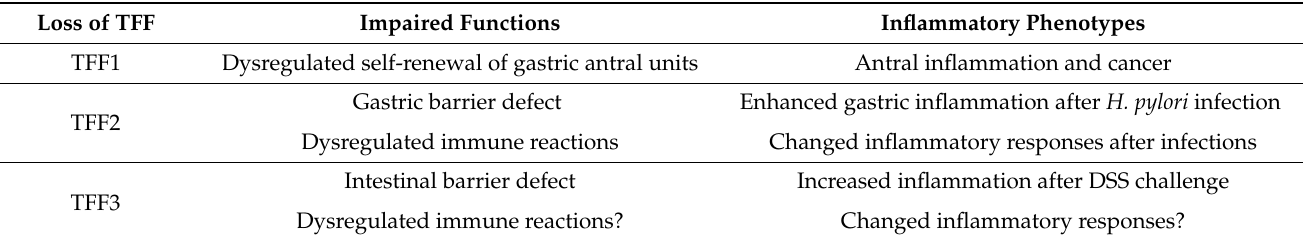
Table 1. TFF peptides and their downstream links to